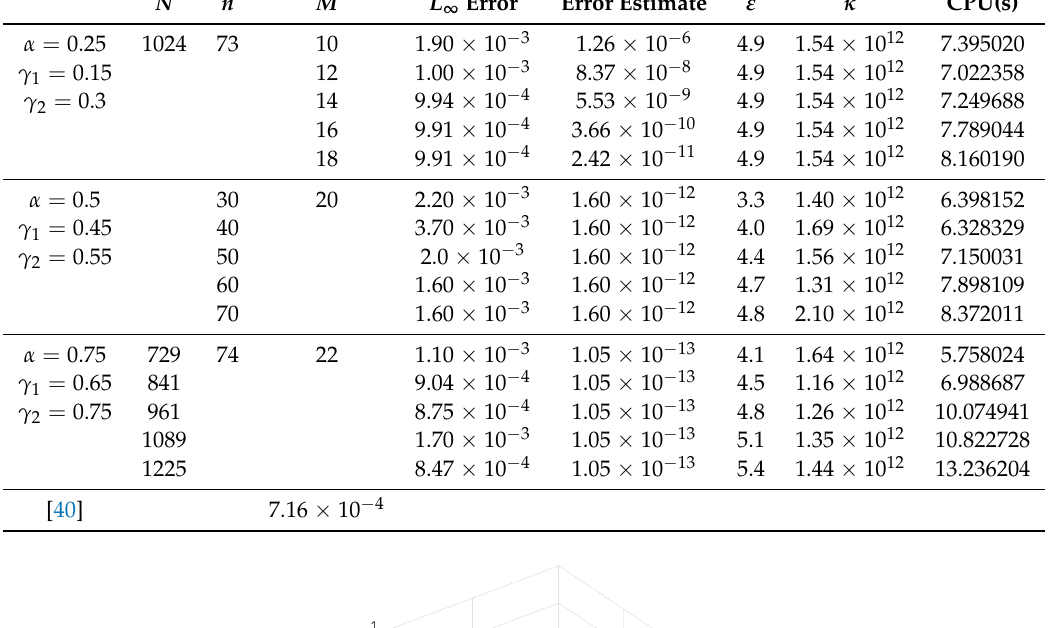
Table 1. Numerical results for the fractional partial integro-differential equations (FPIDEs) in the square domain.